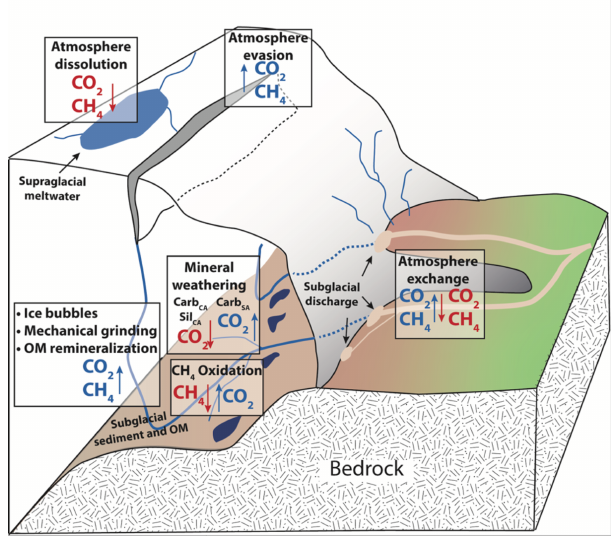
Figure 1. Conceptual diagram of subglacial sources and sinks of CO 2 and CH 4 . Arrows indicate the direction of fluxes. Boxes rep- resent processes, and sources of gases to subglacial meltwaters are indicated by blue text, while sinks of gases to subglacial meltwater are indicated by red text. Gas bubbles, mechanical grinding, and OM remineralization are grouped because all are CO 2 and CH 4